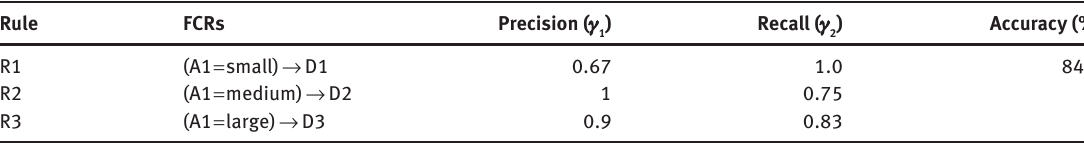
Table 4: FCRs Discovered from the Example Data